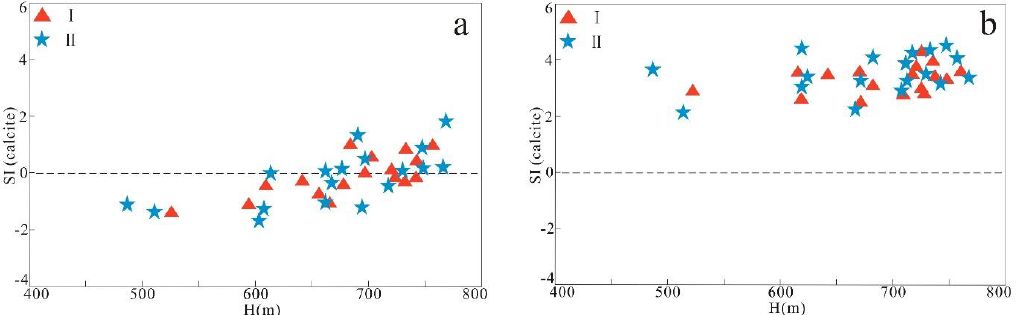
Figure 11. Plots of saturation index (SI) for ( a ) calcite and ( b ) dolomite against H in the Shizhuangnan